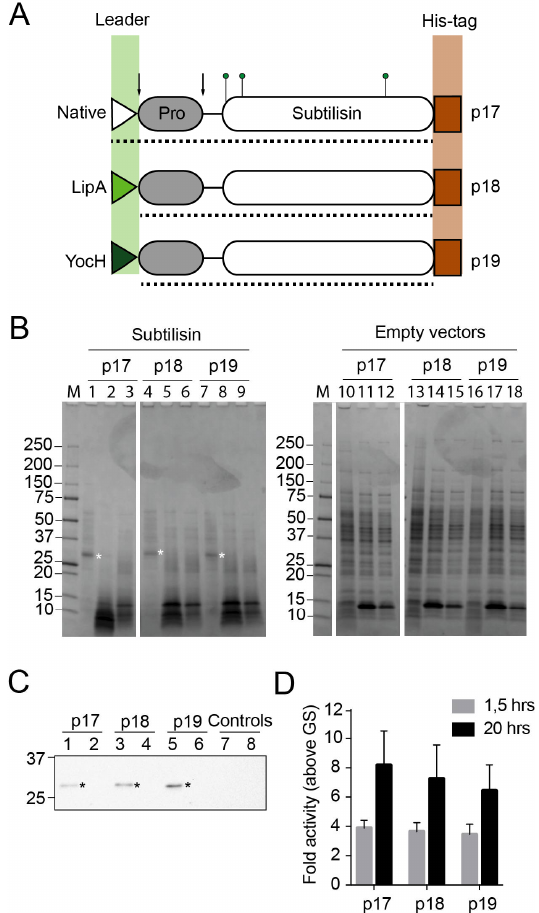
Figure 3. Recombinant expression and activity of subtilisins from FX-compatible Bacillus vectors. ( A ) Cartoon of recombinant subtilisin versions expressed from p17, p18 and p19 vectors, showing the leader sequence (triangles), pro-domain (grey boxes), catalytic domain (white boxes) and C-terminal histidine affinity tag (brown rectangles). Green pins point to residues involved in catalysis (catalytic triad). Dotted line shows the region of the protein encoded by the sub-cloned Bacillus licheniformis DSM13 apr gene. In the p18 and p19 vectors, the vector-encoded LipA or YocH leader sequences (green triangles) replace the native leader sequence (white triangle) in subtilisin, respectively. Arrows show processing sites for leader sequence removal and pro-domain cleavage. Illustration is drawn to scale; ( B ) SDS-PAGE analysis of recombinant subtilisins expressed in B. subtilis WB800N (left panel) and empty vector controls (right panel). Lanes 1, 4 and 7 show supernatant fractions from cultures expressing subtilisin from p17, p18 and p19, respectively. Lanes 2, 5 and 8 contains soluble fractions from cleared cell lysates. Lanes 3, 6 and 9 contains insoluble fractions from cell lysates. Lanes 10–18 are organized accordingly, but contain fractions from cultures with empty vectors (subtilisin is replaced with the GS-linker). M, Precision Plus protein standard are shown to the left of both panels; ( C ) Immunoblot of recombinant subtilisin using antibodies against the C-terminal his-tag. Supernatants and soluble fractions of subtilisin expression from p17 (lanes 1–2), p18 (lanes 3–4) and p19 vectors (lanes 5–6) in B. subtilis WB800N, respectively. As control, fractions from expression of empty p17 are shown in lanes 7–8. Asterisks indicate bands that correspond to the expected mass of matured subtilisins (28 kDa). Two bands from the Precision Plus protein standard are shown to the left; ( D ) The supernatants of B. subtilis WB800N expression cultures containing the subtilisin versions (expressed from p17, p18 and p19 vectors, respectively) were screened for proteolytic activity against BODIPY-conjugated casein for 1.5 and 20 h. Fluorescence values were made relative to empty vector controls (GS-linker), and errors show deviation in three biological replicates.